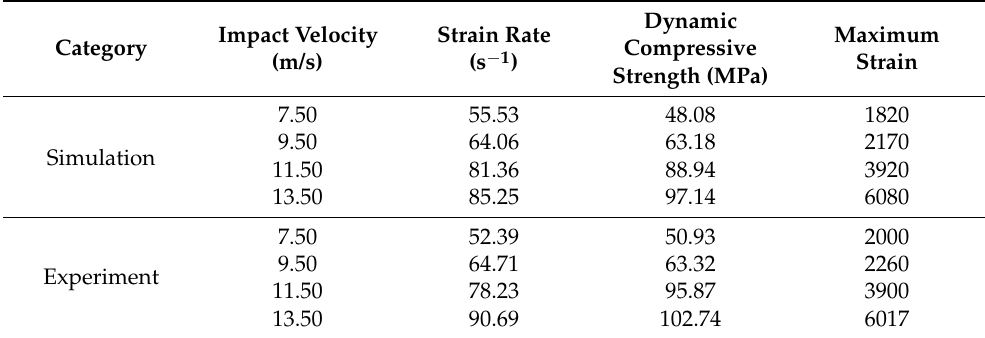
Figure 23. The numerical calculation results using the HJC model with the calibrated parameters. Table 9. Comparison between the simulation and experiment for the dynamic mechanical characteristics of sandstone.